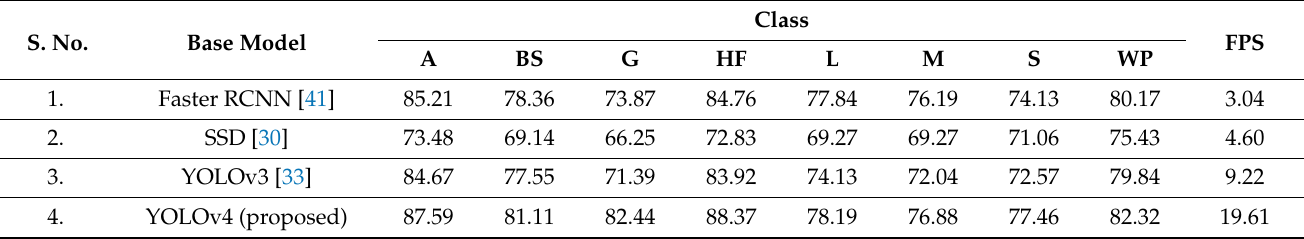
Table 6. Comparative